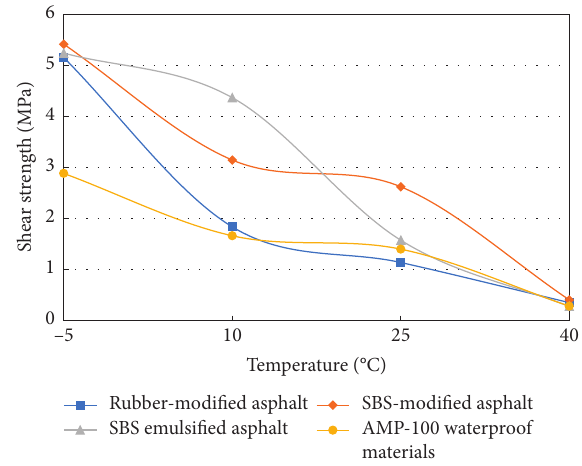
Figure 6: Shear strength of four types of waterproof adhesive layers at different